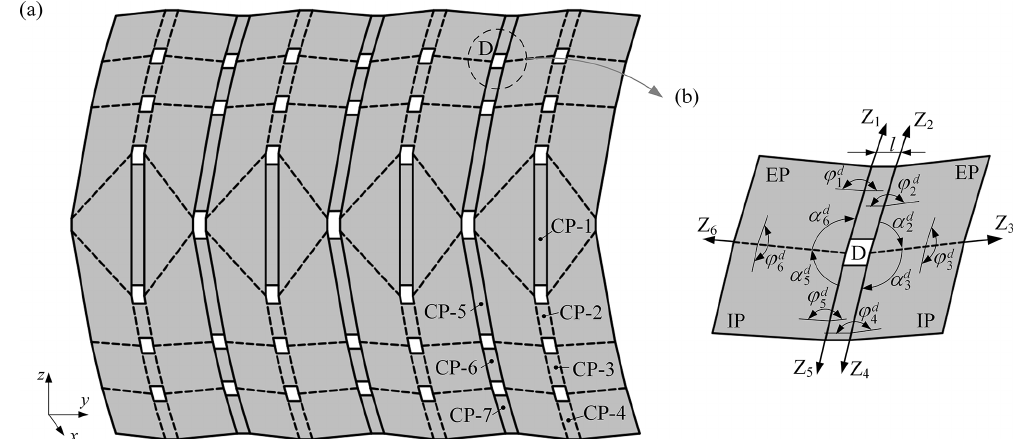
Figure 6. Cylindrical deployable origami pattern: (a) the origami pattern composed of four identical deployable strings, (b) U S -D.